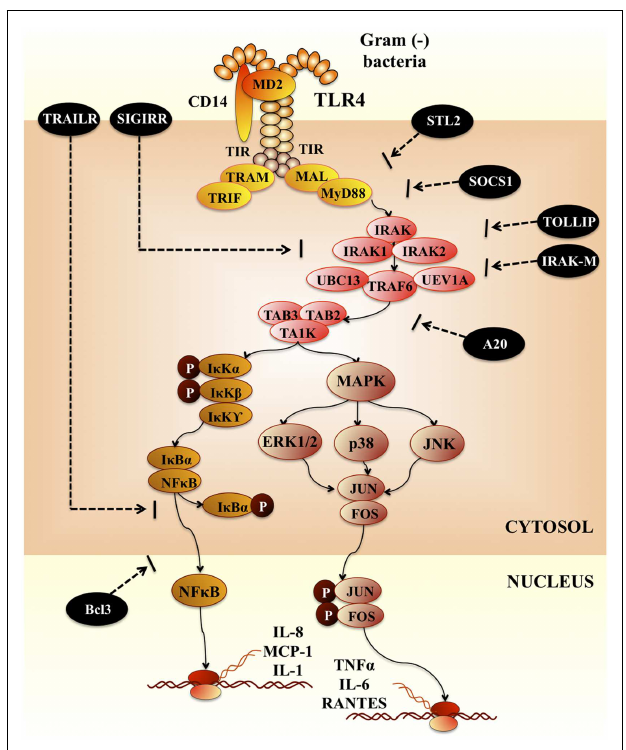
FIGURE 1 | Toll-like receptor-4 signaling pathway